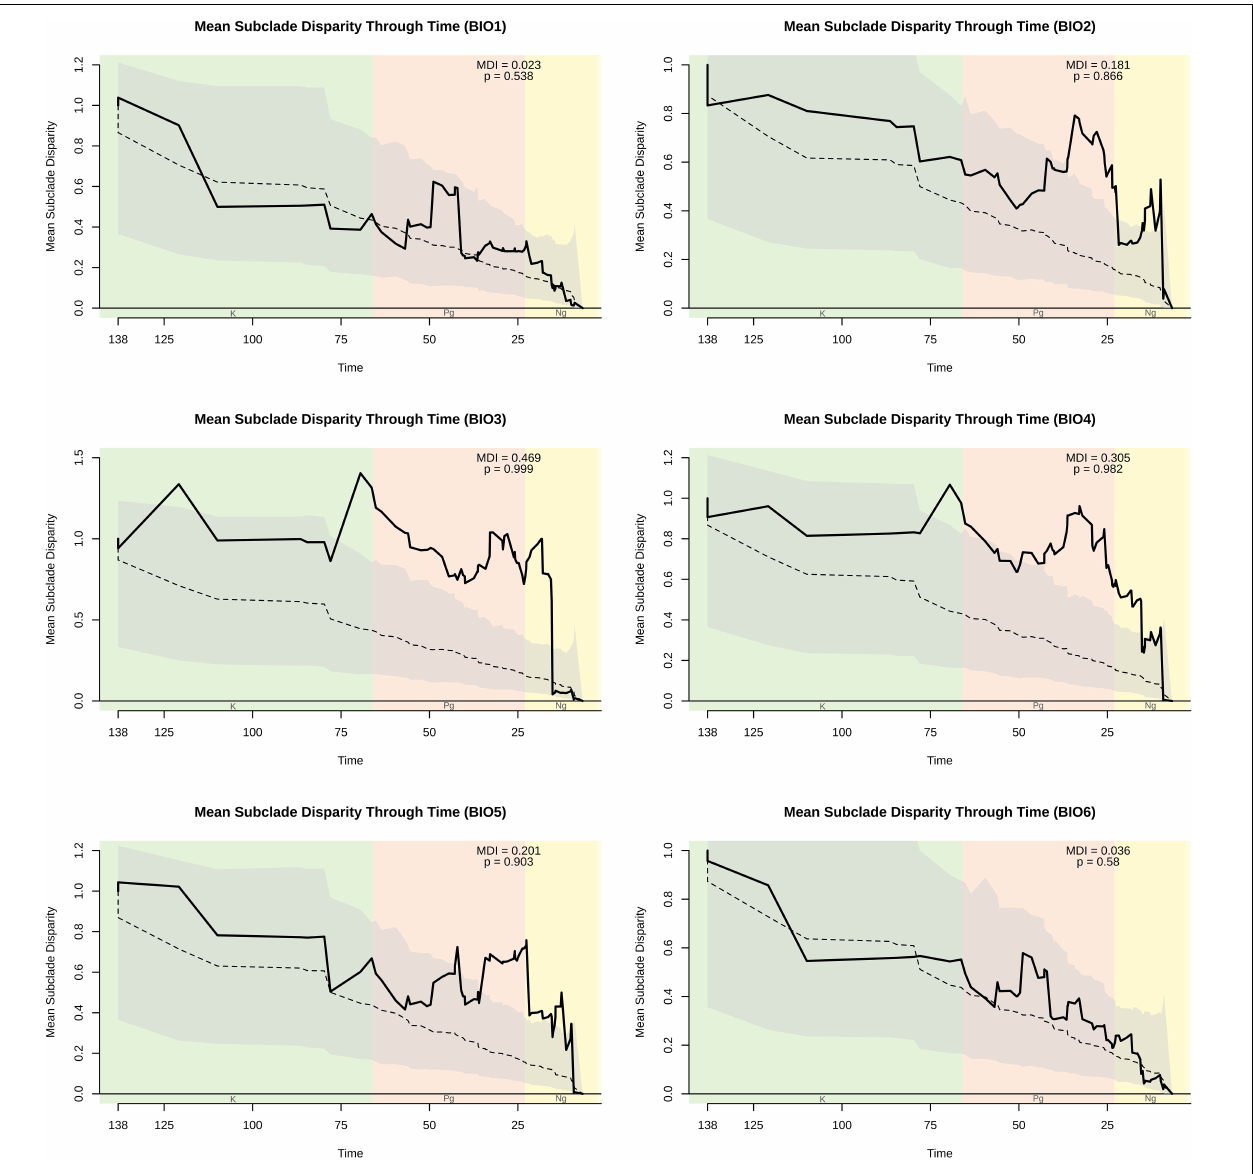
FIGURE 2 | Disparity through time (DTT) plot of BIO1–BIO6 variables. The solid line indicates the observed subclade disparity. The dashed line indicates median estimates from simulated data, and the gray cloud indicates the 95% confidence interval derived from simulated data. The MDI value and its associated p -value are provided. Vertical shading indicates geologic periods, which are abbreviated at the bottom. Plots and values are based on analyses of the MCC tree, while a summary of values obtained from the sample of trees derived from the posterior is provided in Supplementary Table 1 . DTT plots of BIO7–BIO19 are shown in Supplementary Figures 2 , 3